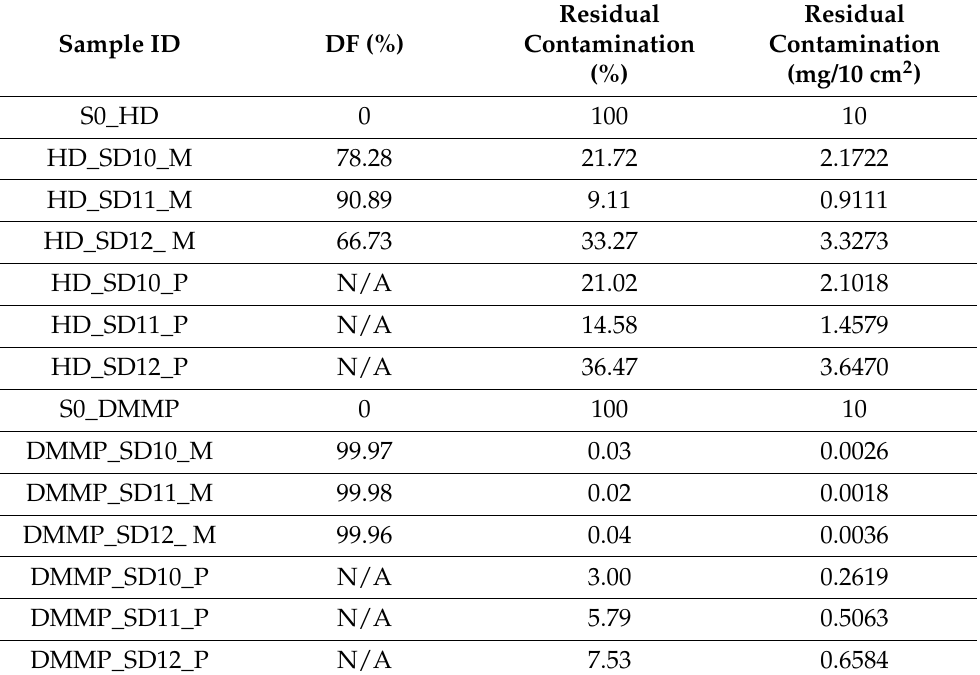
Table 7. Evaluation of chemical decontamination efficacy with the aid of GC-MS results.